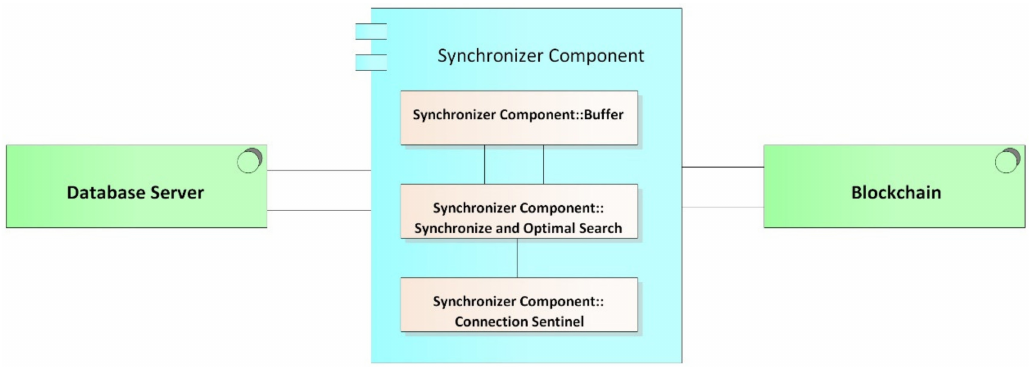
Figure 9. Synchronizer bu ff